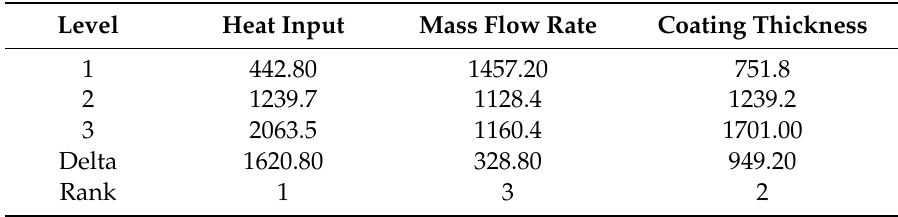
Table 15. Table of responses for